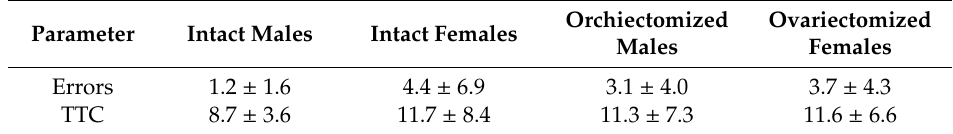
Table 2. Mean ± SD number of errors (choices of S − ) and trials required to reach the learning criterion (TTC) in the Training phase by dogs of di ff erent sex and reproductive